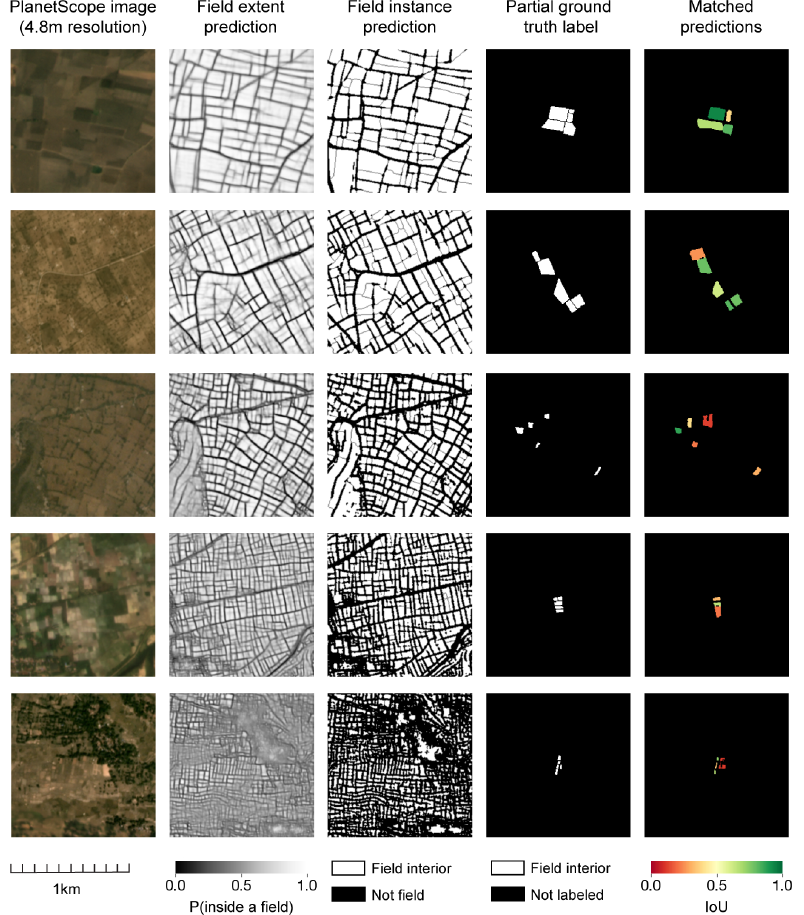
Figure A6. Examples of using PlanetScope to delineate fields in India. ( Left to right )